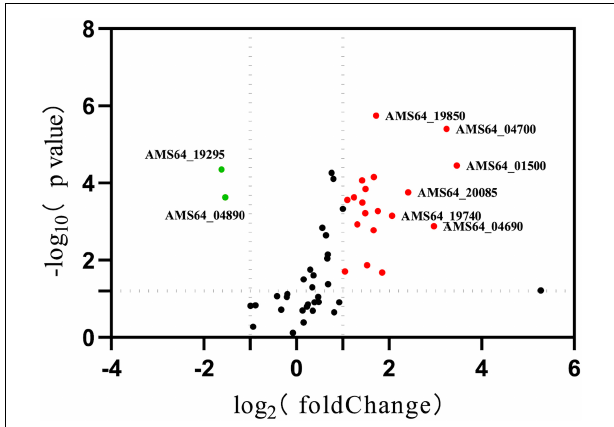
FIGURE 3 | Expression of genes related to purine metabolism. Green represents down-regulated genes with significant differences. Red indicates up-regulated genes with a significant difference. *represents p < 0.05.